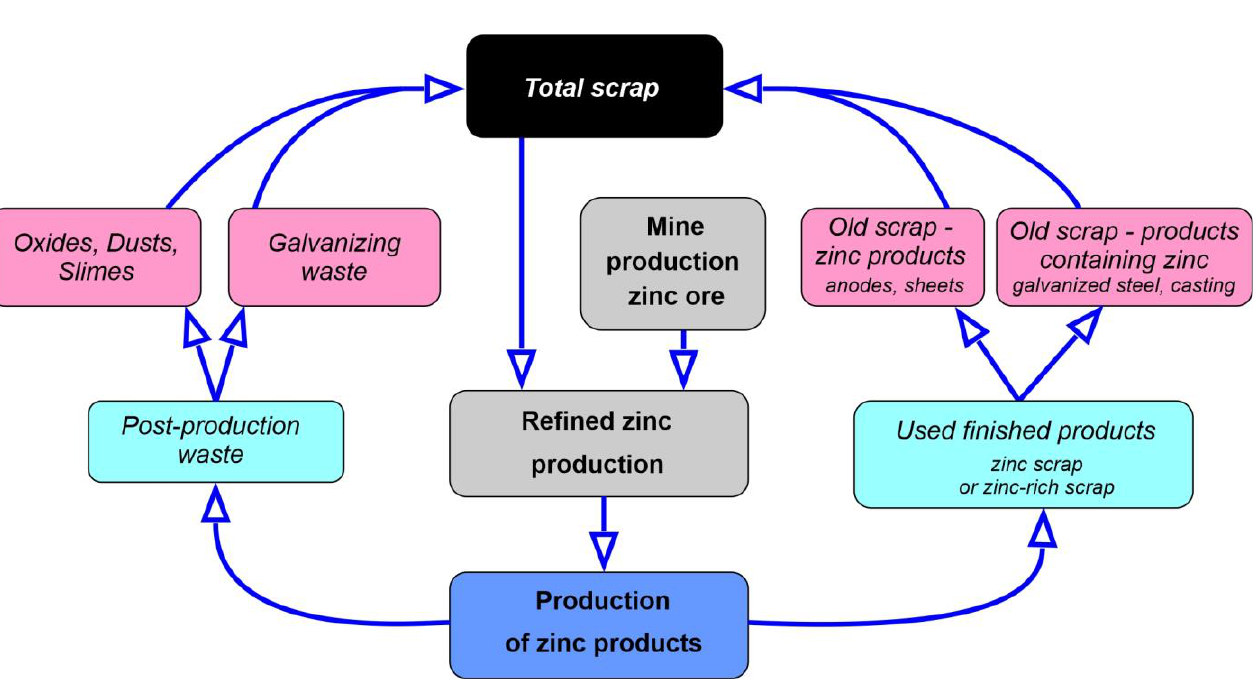
Figure 7. Material cycle in zinc recycling, figure prepared based on data taken from [69].